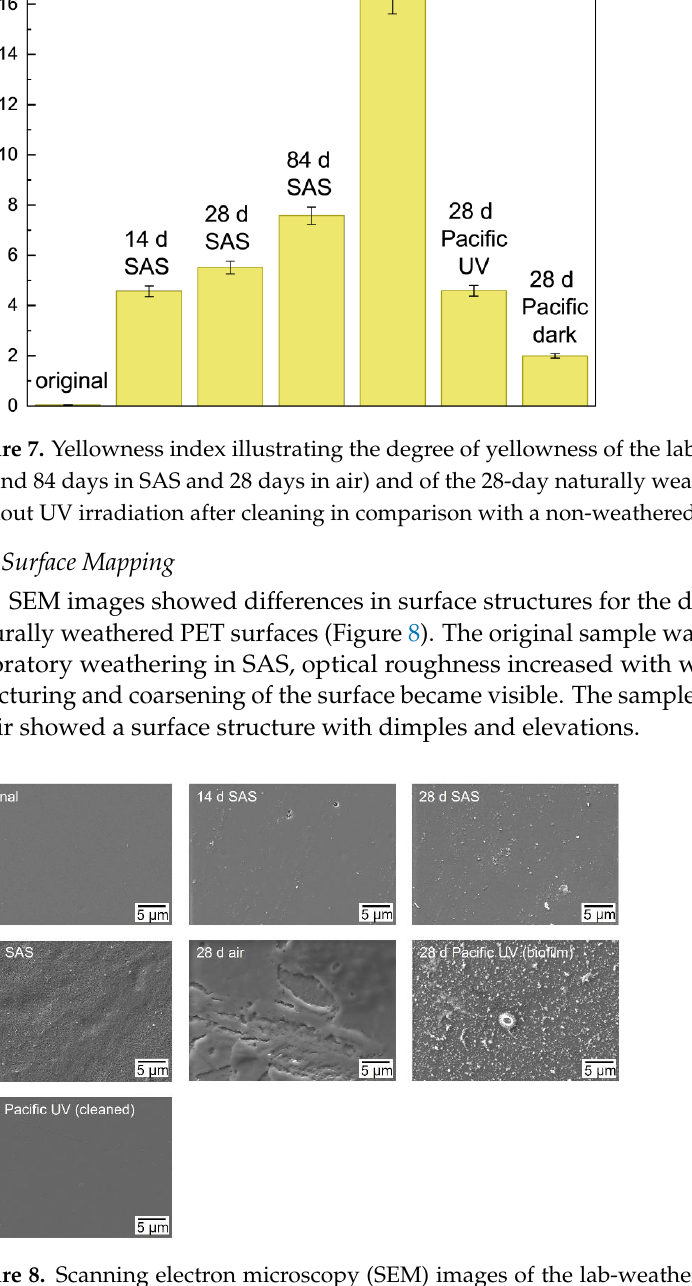
Figure 8. Scanning electron microscopy (SEM) images of the lab-weathered samples (14, 28, and 84 days in SAS and 28 days in air) and the 28-day naturally weathered sample (Pacific Ocean under sunlight) in comparison with a non-weathered original PET sheet. The naturally weathered sample is shown as taken from the mesocosm with biofilm on the one hand and after cleaning on the other